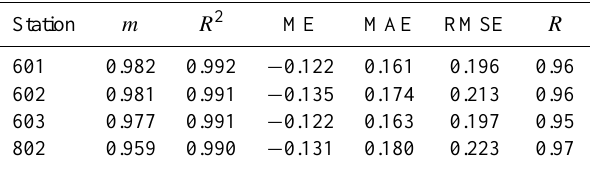
Table 2. Mean error (ME – mmday − 1 ), mean absolute error